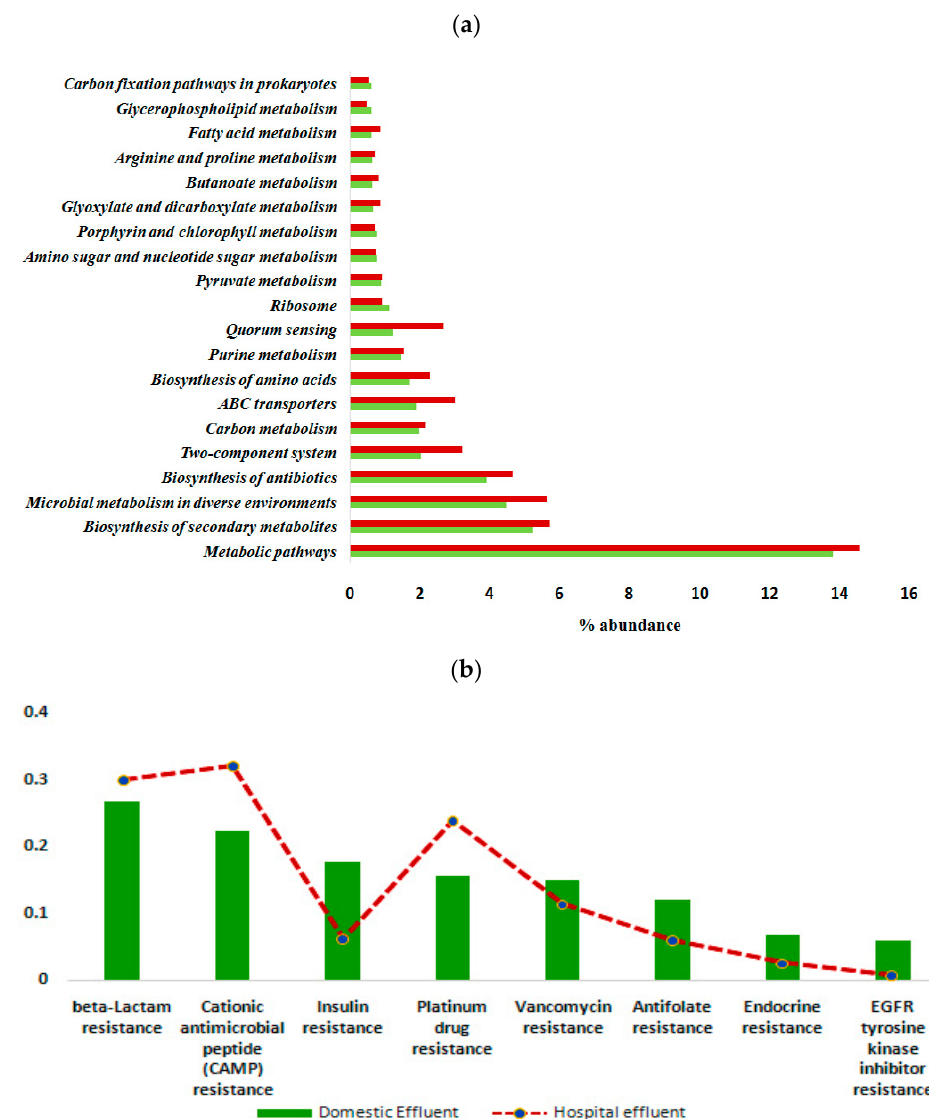
Figure 5. ( a ) Relative abundance (%) of different bacterial pathways detected in the wastewater samples (differences in the overall abundance of metabolic genes in the collected effluent samples were significant; p = 0.021). Red bar represented HWW samples and green bar represented DWW samples. ( b ) Various antibiotic resistance pathways identified in domestic and hospital effluent